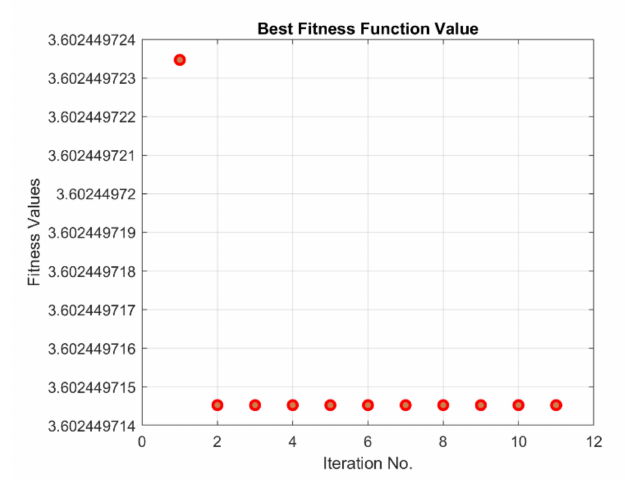
Figure 10. Best fitness value of α fuzzy rule tuning.